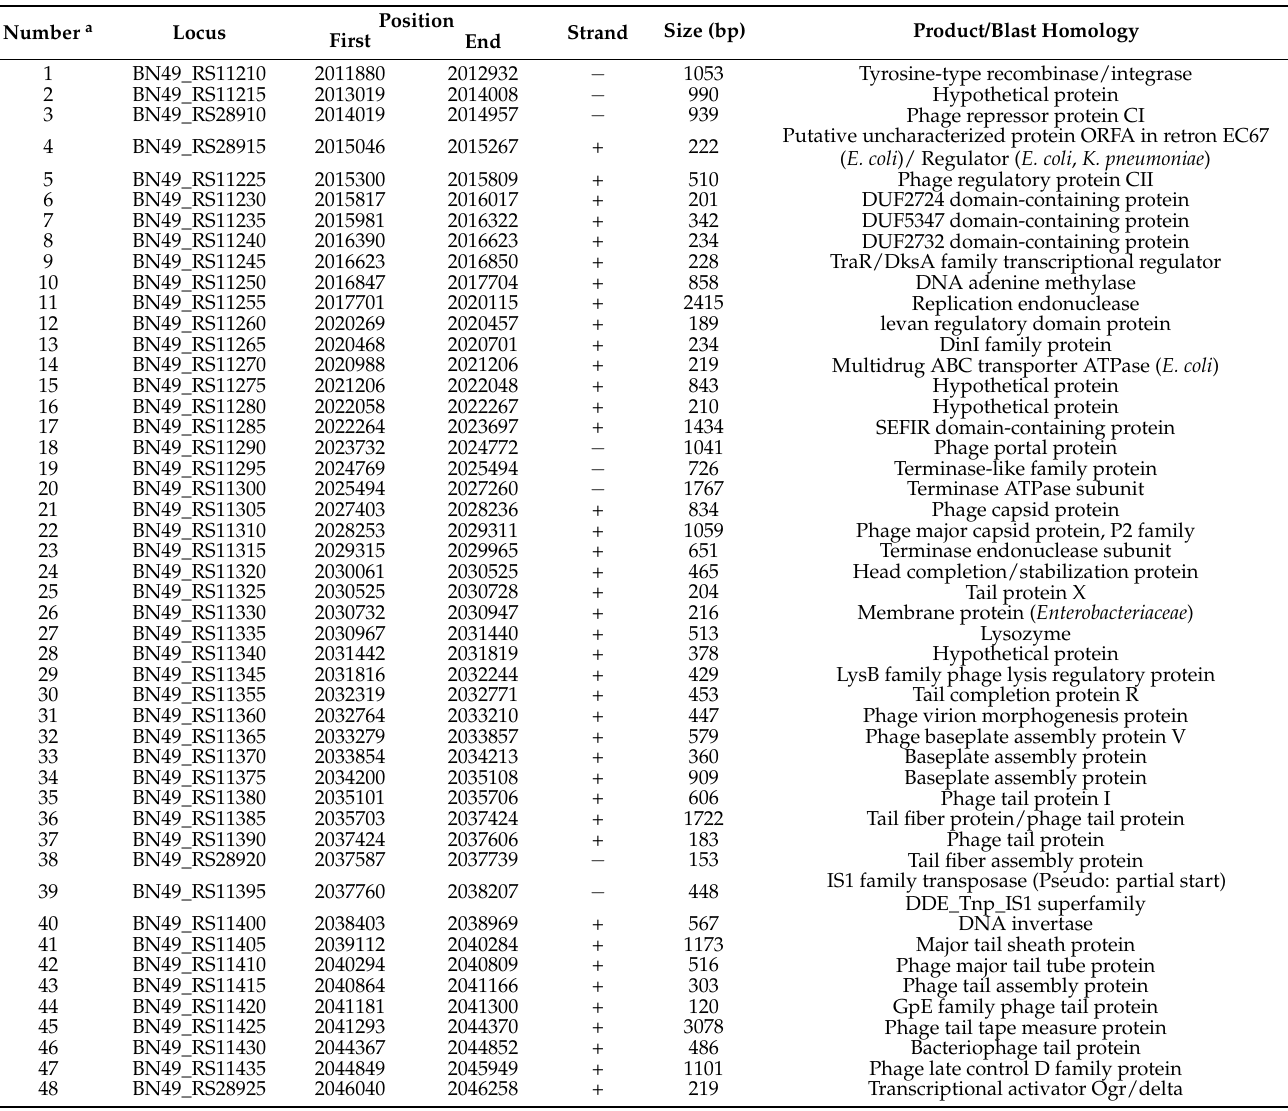
a Number correspond with numbers in Figure